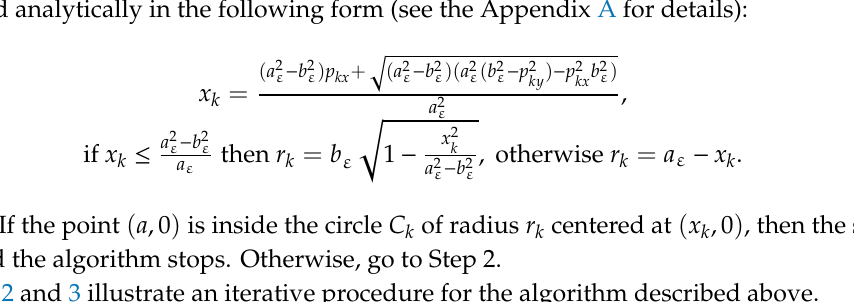
Figure 4. Illustration of Stage 2 . and the feasible set V is defined by the following system of inequalities: 0   , 0 r